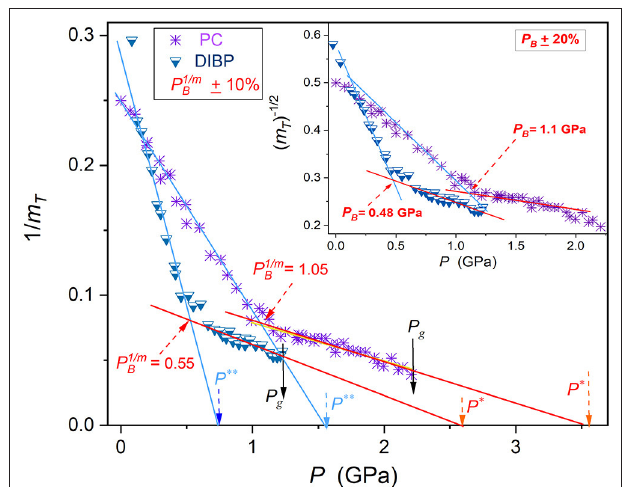
FIGURE 4 | The universal previtreous behavior of the reciprocal of the pressure apparent fragility for super-pressed propylene carbonate and diisobutyl phthalate, based on experimental data from Figure 1 . Results of the linear regression fit (Equations 15, 16) are collected in Table 1 . The solid arrows indicated glass transition pressures, and the dashed (orange) arrows extrapolated singular pressures P ∗ g = P g + 1 P ∗ g and P ∗ B = P 1 / m B + 1 P ∗ B . Dynamical crossover pressures P 1 / m B are indicated.